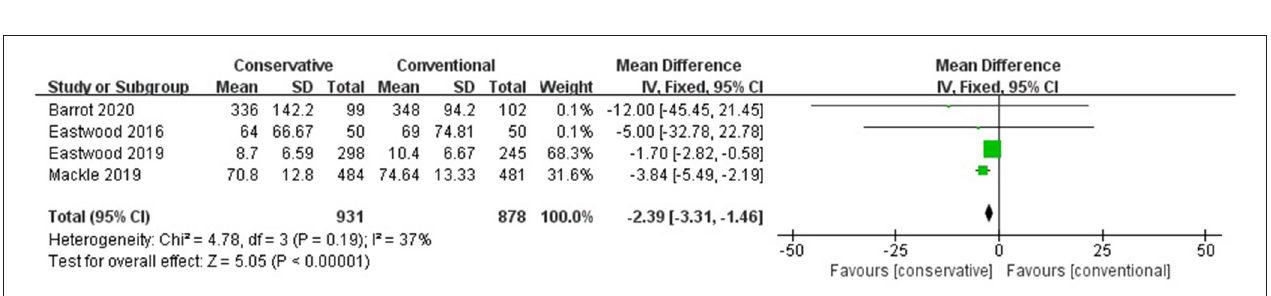
FIGURE 4 | Hospital LOS. CI, confidence interval; LOS, length of stay; MD, mean difference; SD, standard deviation.